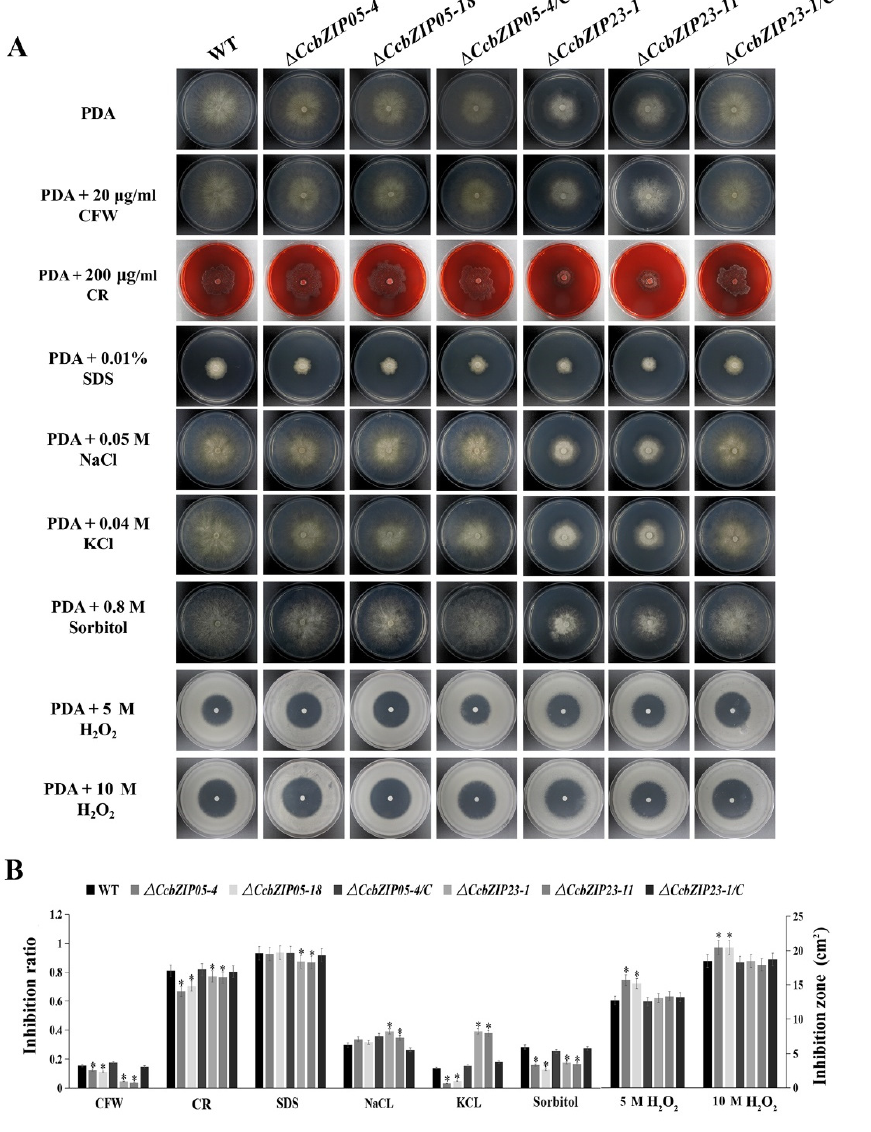
Figure 7. Involvement of ∆ CcbZIP05 and ∆ CcbZIP23 mutants in response to the abiotic stresses. ( A ) Comparison of the wild-type, gene deletion mutants, and complemented strains in colony morphology and stress tolerance. In oxidative stress test, conidial suspensions (1 × 10 5 spores) of wild-type, gene deletion mutants, and complemented strain were spread on PDA plates. Sterile filter paper disks (5-mm diameter) were placed in the center of the plates, and 5 μ L 5 M or 10 M H 2 O 2 solution was added to each paper disk. The plates were incubated at 25 °C for 4 days, and the inhibition zones were observed and measured ( B ) The bar chart shows the inhibition rate or inhibition zone of the individual strains under different abiotic stresses shown in part ( A ). Error bars represent the standard deviations based on three independent replicates. Asterisks indicate significant differences at p < 0.05.